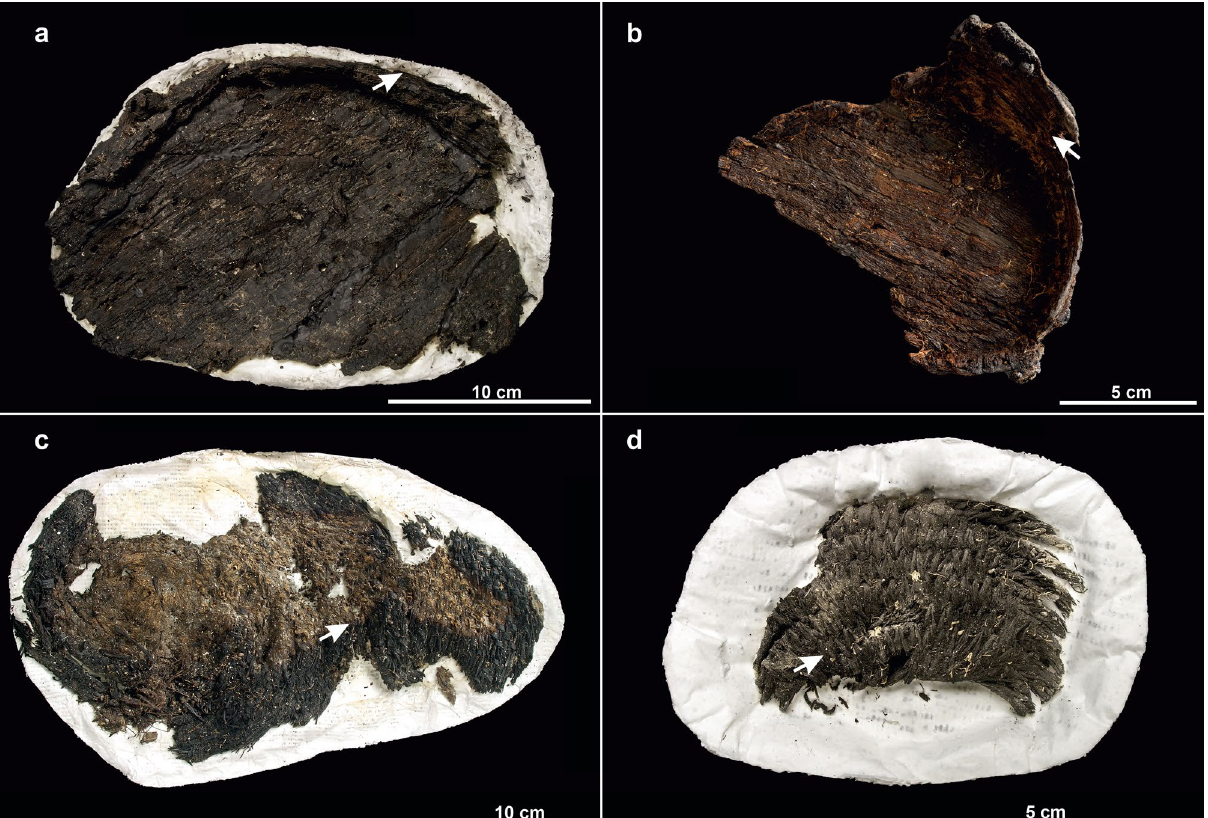
Figure 2. Archaeological objects: ( a ) bark container (sample 5), ( b ) bark container (sample 6), ( c ) coiled basket (sample 7), ( d ) coiled basket (sample 8). The arrows indicate the locations of sampling. Photos: ( a ) Matthias Hoffmann/ALM, ( b ) Yvonne Mühleis/LAD, ( c , d ) Sebastian Böhm/FAU.